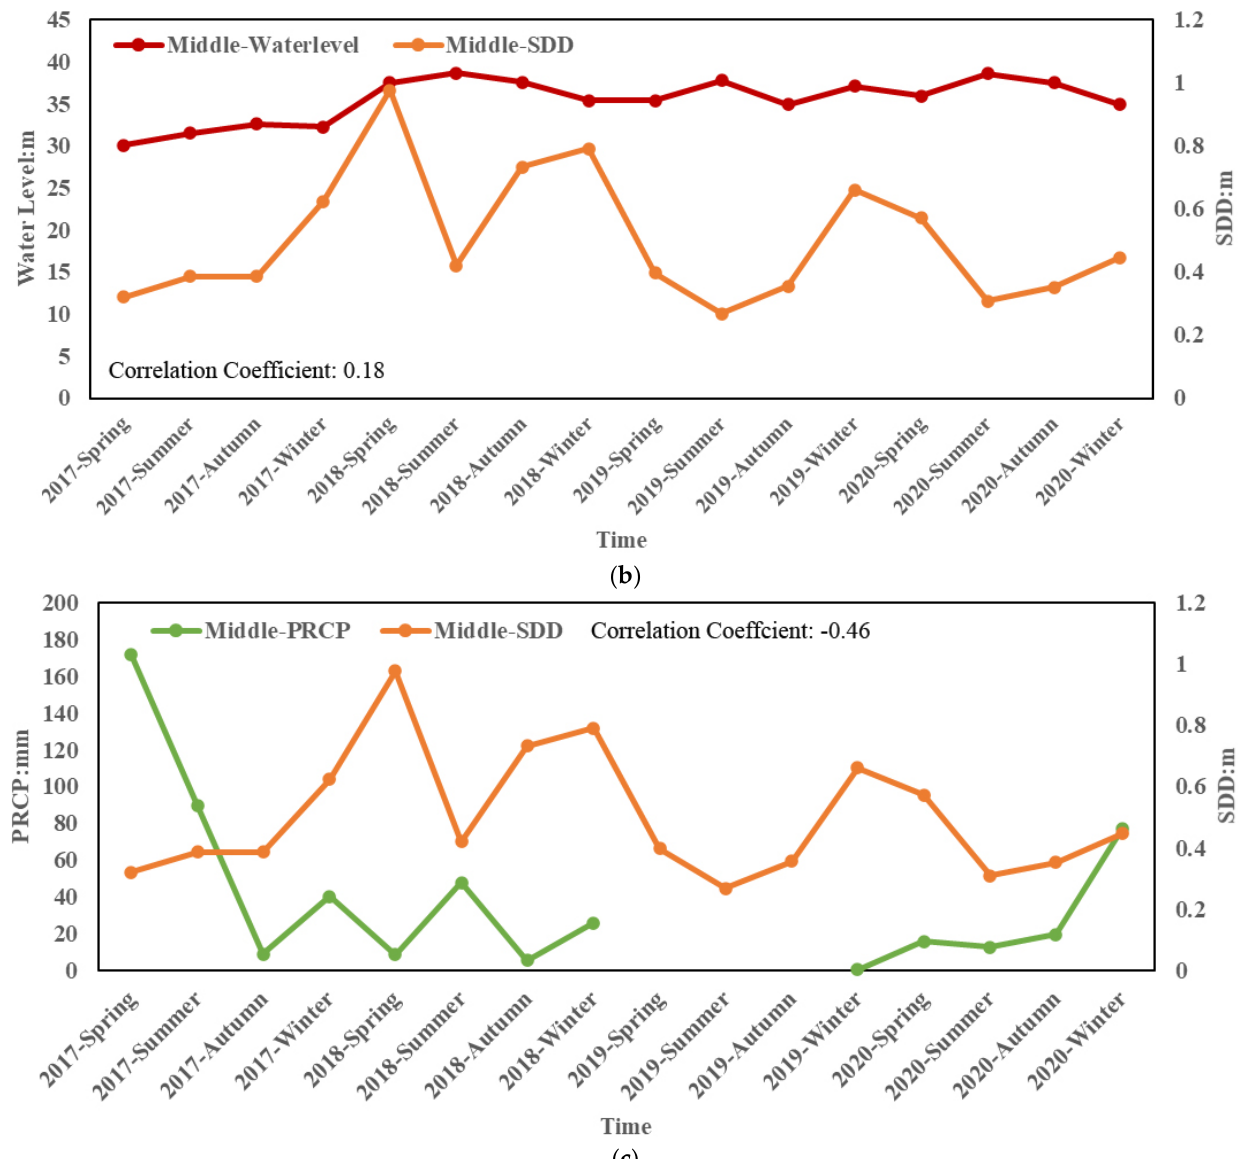
Figure 11. The relationship between the middle reaches of the Yangtze River and runoff, water level, PRCP; ( a ) the relationship between the SDD and runoff; ( b ) the relationship between the SDD and water level; ( c ) the relationship between the SDD and PRCP.